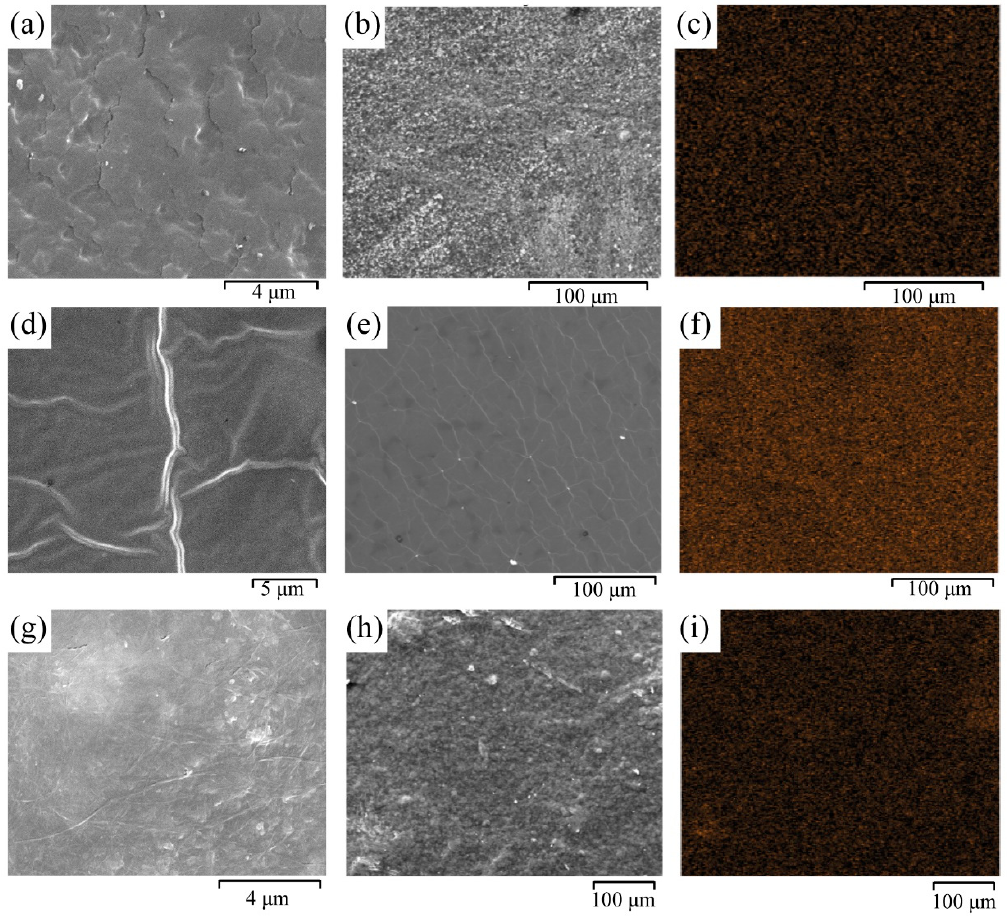
Figure 4. Micrographics and Fe mappings obtained by using Energy Dispersive Spectroscopy (EDS) for 30% superparamagnetic iron oxide nanoparticles (SPIONs) composites: ( a – c ) Ch30; ( d – f ) Col30; and ( g – i ) BC30.